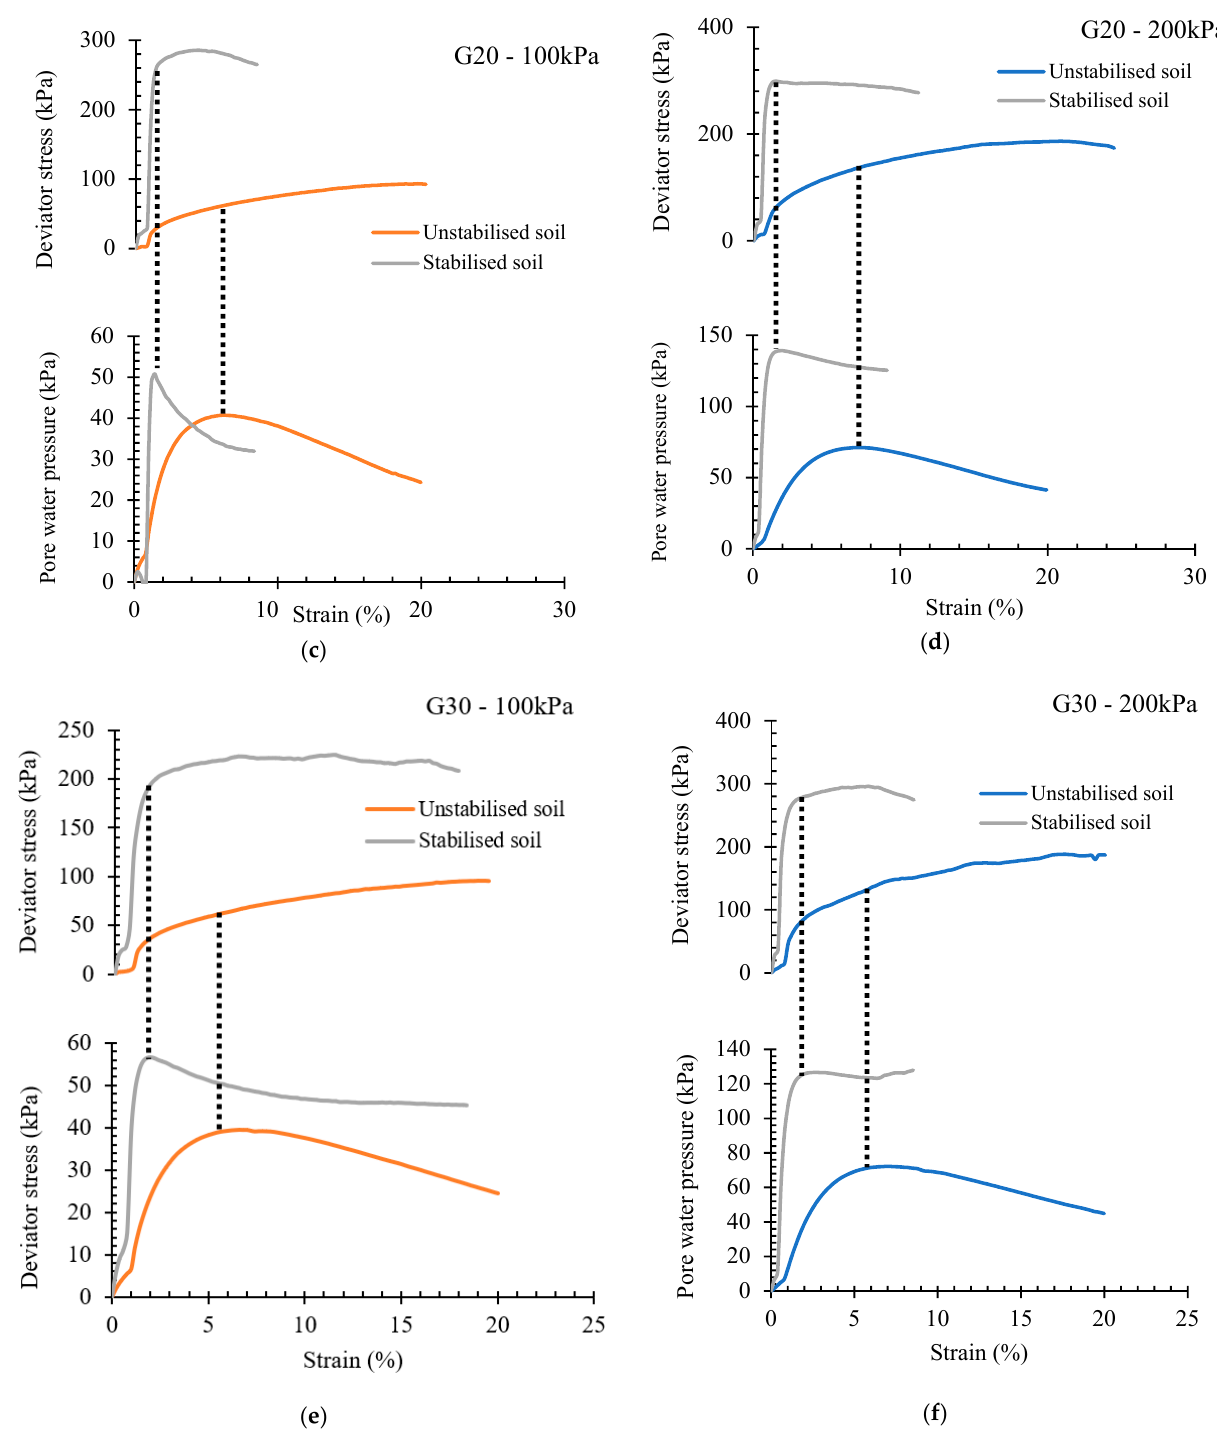
Figure 5. Stress–strain curves with pore pressure changes: ( a ) 10% gypsum content and constant effective pressure of 100 kPa; ( b ) 10% gypsum content and constant effective pressure of 200 kPa; ( c ) 20% gypsum content and constant effective pressure of 100 kPa; ( d ) 20% gypsum content and constant effective pressure of 200 kPa; ( e ) 30% gypsum content and constant effective pressure of 100 kPa; ( f ) 30% gypsum content and constant effective pressure of 200 kPa.